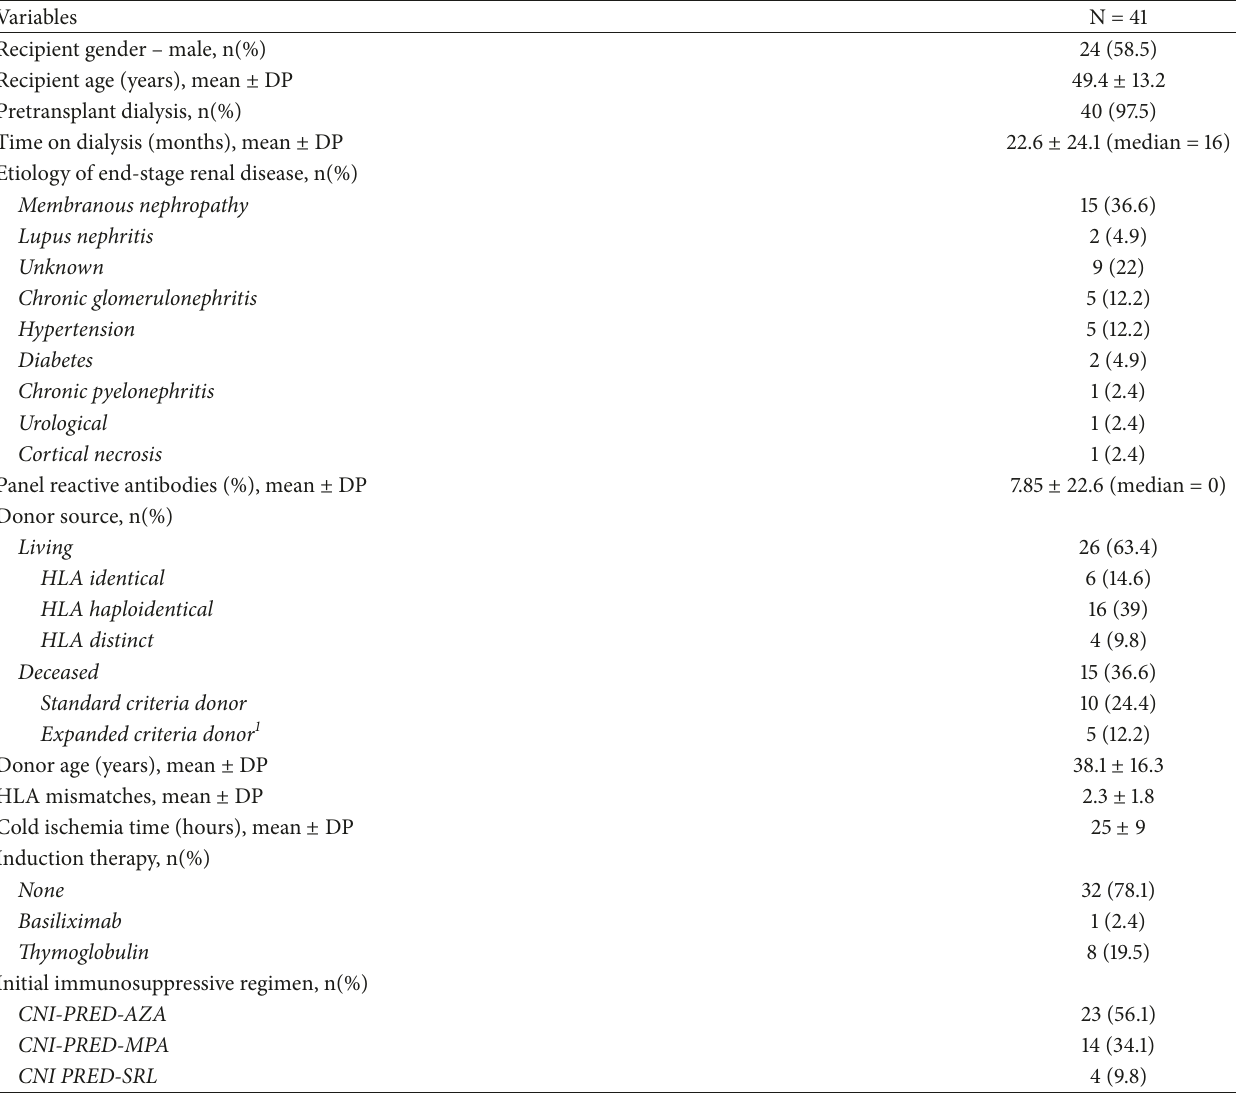
Table 1: Demographic characteristics of patients with posttransplant